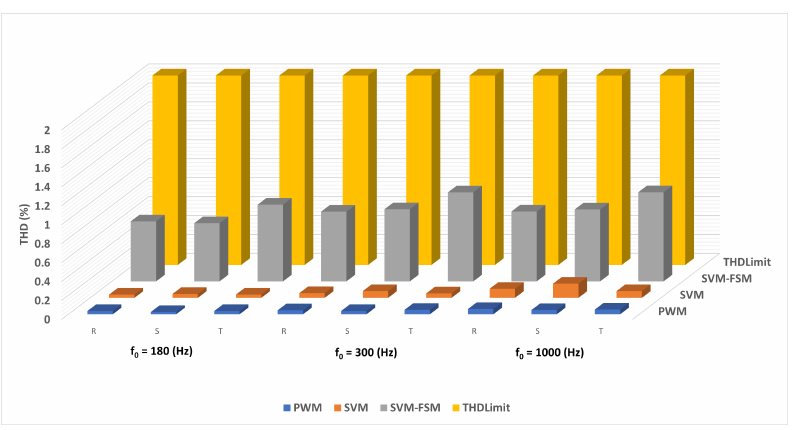
Figure 12. THD limits, according to IEEE Std 519 (2014) (3 ≤ HO < 11).